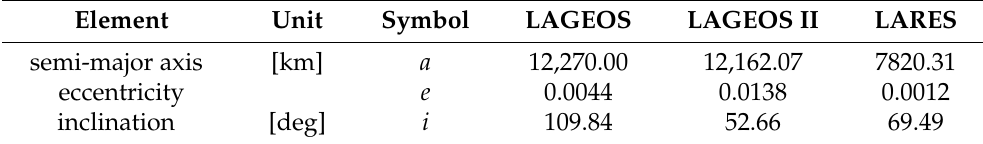
Table 1. Mean orbital elements of the satellites.